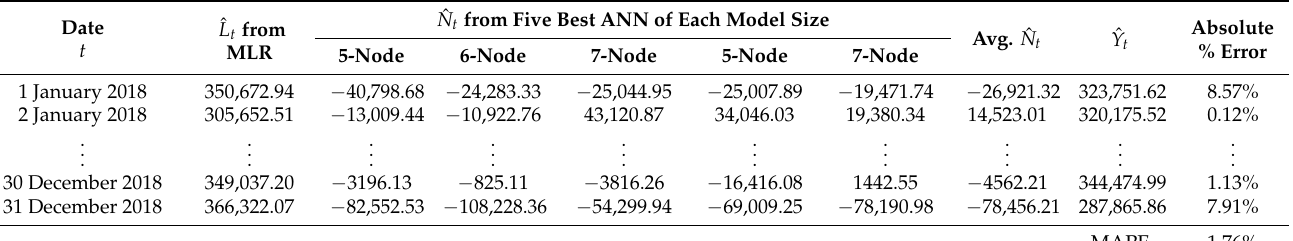
Table 11. Hybrid model of MLR and five best ANN of each model